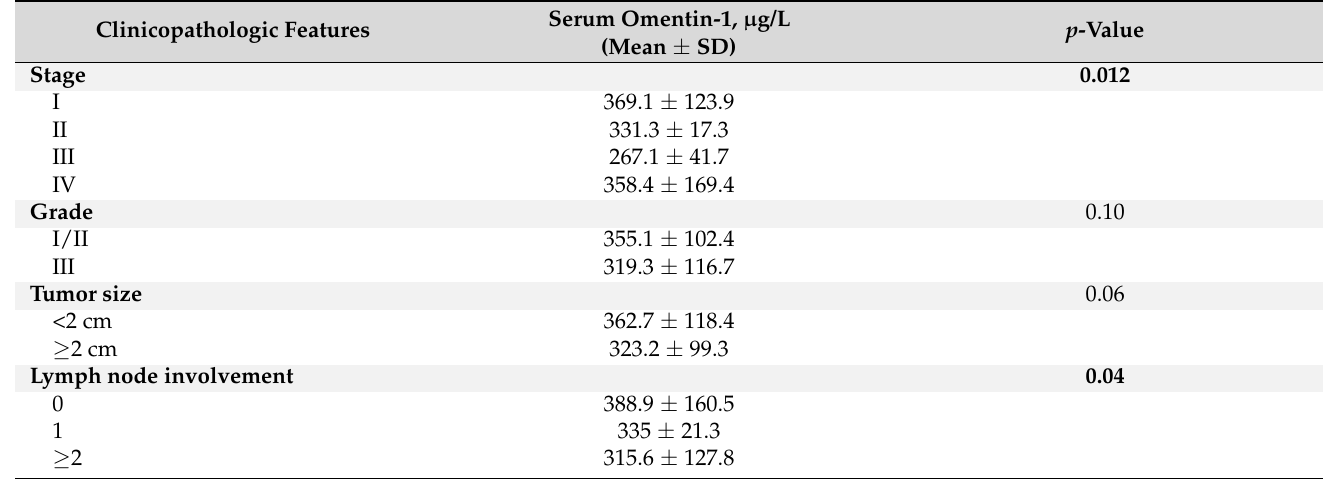
Table 5. Serum omentin-1 ( µ g/L) and its association with clinicopathologic features in 103 cases suffering from post- menopausal breast